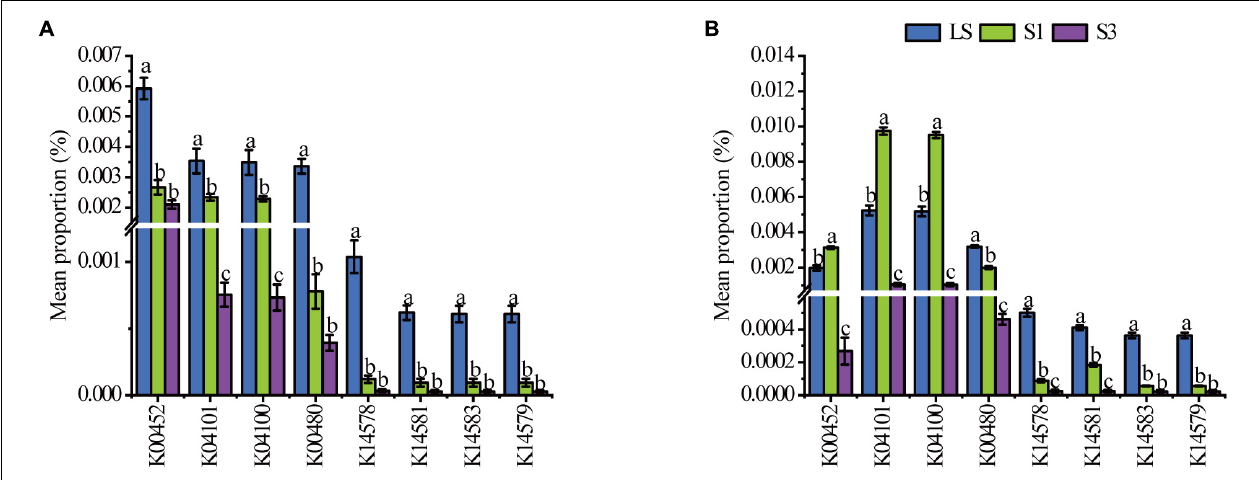
FIGURE 4 | Mean proportions of the functional genes associated with the degradation of PAHs in soil after 7 days (A) and 30 (B) days of incubation. K00452 HAAO; 3-hydroxyanthranilate 3,4-dioxygenase [EC:1.13.11.6]; K04101 ligB; protocatechuate 4,5-dioxygenase, beta chain [EC:1.13.11.8]; K04100 ligA; protocatechuate 4,5-dioxygenase, alpha chain [EC:1.13.11.8]; K00480 salicylate hydroxylase [EC:1.14.13.1]; K14578 nahAb, nagAb, ndoA, nbzAb, dntAb; naphthalene 1,2-dioxygenase ferredoxin component; K14581 nahAa, nagAa, ndoR, nbzAa, dntAa; naphthalene 1,2-dioxygenase ferredoxin reductase component [EC:1.18.1.7]; K14583 nahC; 1,2-dihydroxynaphthalene dioxygenase [EC:1.13.11.56]; K14579 nahAc, ndoB, nbzAc, dntAc; naphthalene 1,2-dioxygenase subunit alpha [EC:1.14.12.12 1.14.12.23